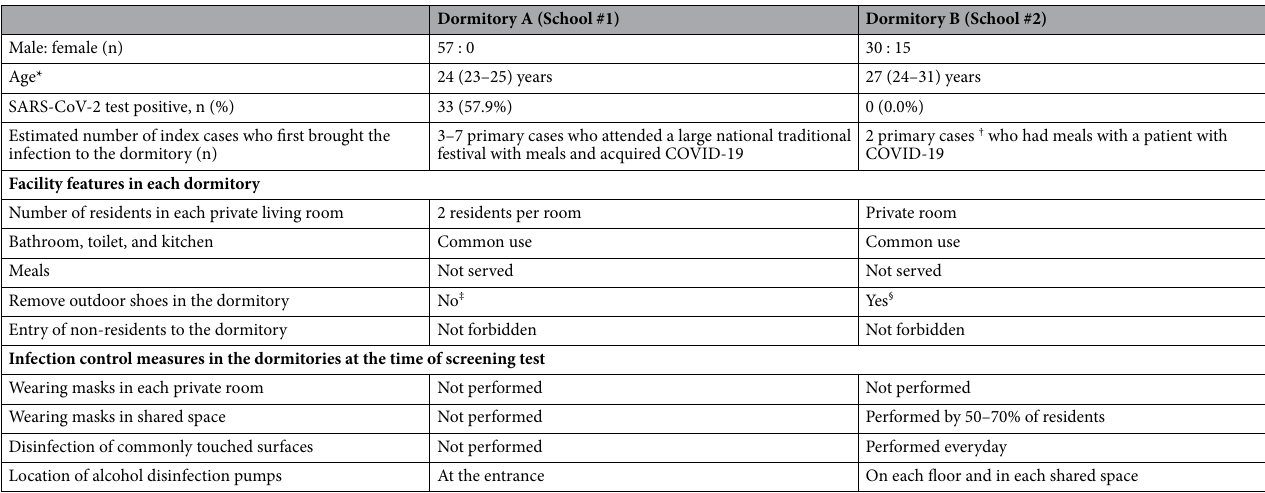
Table 3. Facility features and infection control measures in two dormitories with different SARS-CoV-2 test positive rates. *Median and interquartile range (25–75 percentile). † These two patients noticed dysosmia several days after having meals with a COVID-19 patient and were later tested positive with SARS-CoV-2 in a medical facility different from our testing center. Both stayed in the dormitory for 2–3 days after the manifestation of their symptoms. ‡ Shoe boxes are present in each private living room. Most residents remained barefoot in the living room. § The shoe box is placed at the entrance of the dormitory. About half of the residents further changed their slippers when they entered the private living